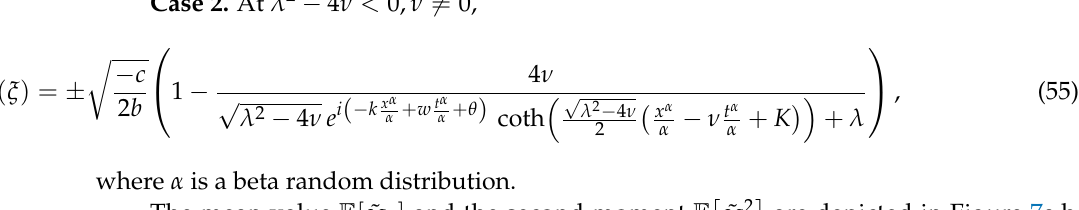
] and the second moment E (cid:2) ˜ sq 2 3